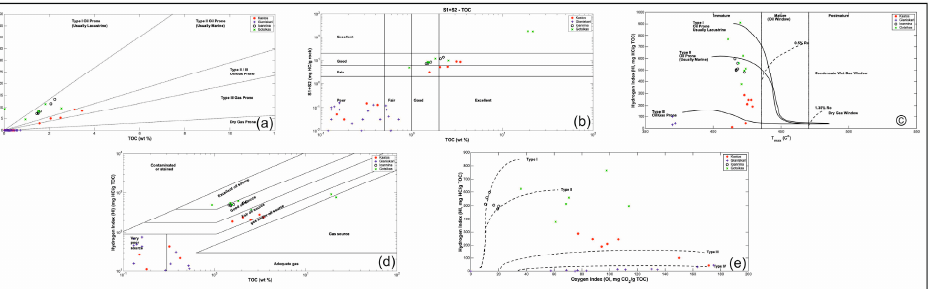
Figure 7. ( a ) S2–TOC and kerogen characterization of samples, ( b ) Diagram S1+S2–TOC, ( c ) Diagram HI–Tmax, ( d ) Diagram HI–TOC, and ( e ) Van Krevelen diagram for